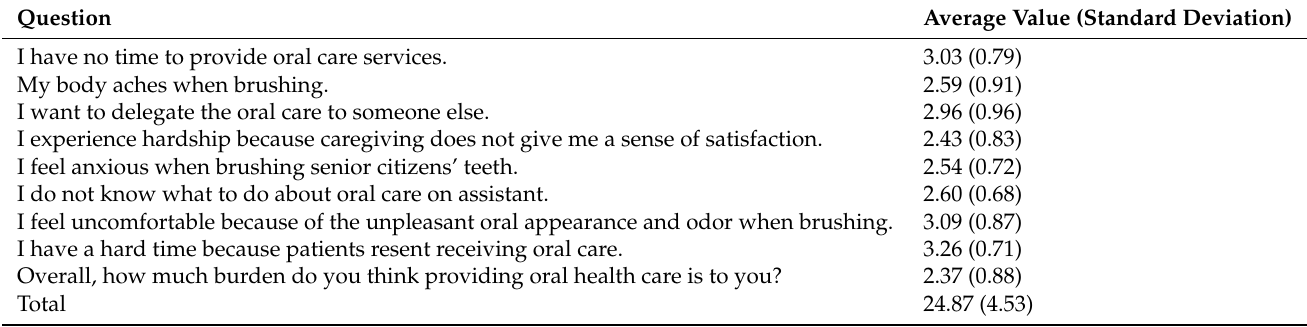
Table 3. Oral Health-related Caregiver Burden Index scores.